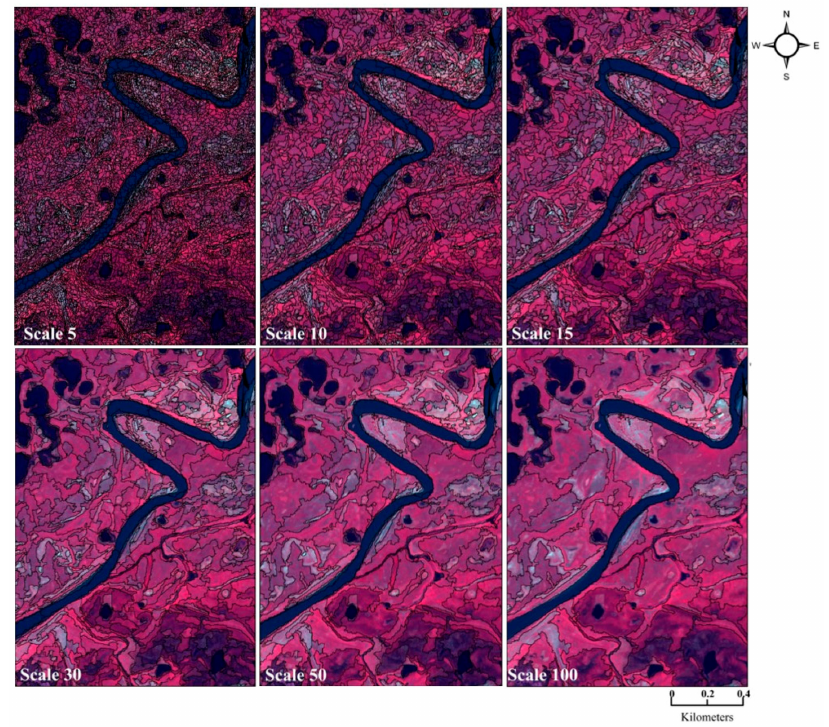
Figure 4. Example of image-objects created at different segmentation scales using parameters of shape = 0.1 and compactness = 0.5. The number of objects created across the study area decreased with increasing segmentation scales: 5 (5,191,948 objects), 10 (1,474,823 objects), 15 (711,351 objects), 30 (204,026 objects), 50 (81,026 objects), and 100 (23,091